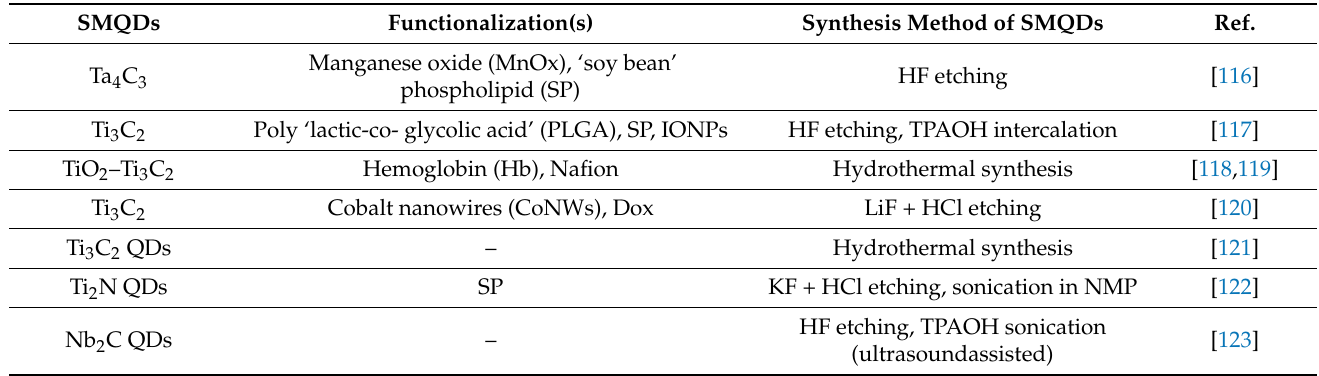
Table 2. A summary of the different SMQDs synthesis